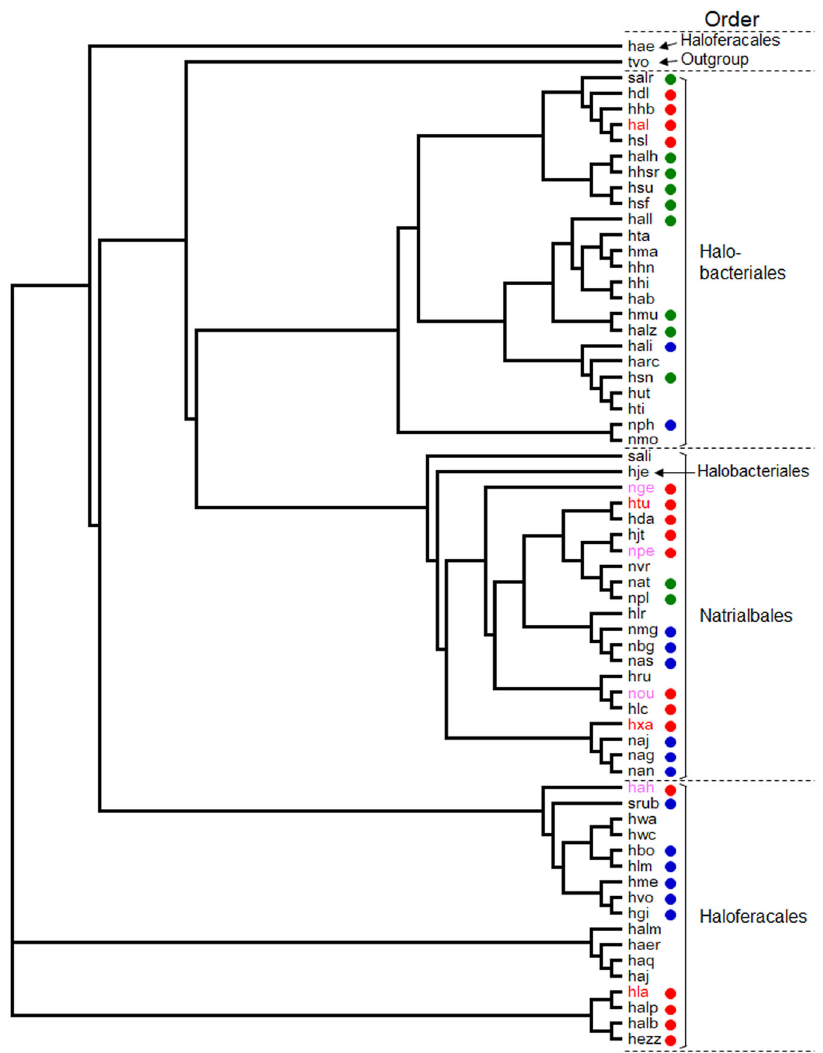
Fig. 6 Relationship between the presence of the three nucleoside metabolic pathways and phylogenetic positions of halophilic archaea. The phylogenetic tree was constructed using 16S rRNA gene sequences. A sequence from Thermoplasma volcanium (tvo) was used as an outgroup. The colors of the circles correspond to those of the nucleoside metabolic pathways in Fig. 5. Organisms shown in red and pink codes indicate the halophilic archaea shown in Fig. 3. The organisms in red codes show those whose proteins were actually examined in this